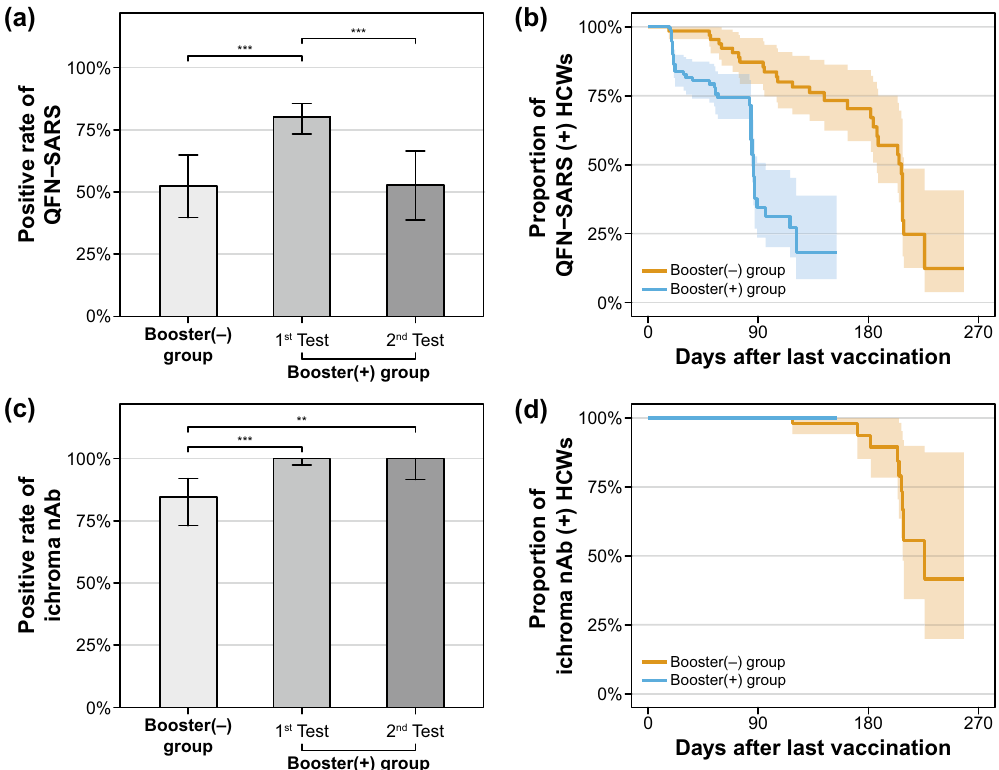
Figure 1. Positive rates of QFN-SARS ( a ) and ichroma nAb ( c ) before and after booster shot. Asterisks indicate significant differences (** p < 0.01, *** p < 0.001), and error bars indicate 95% confidence intervals of the positive rates. Kaplan–Meier curves displaying the proportion of QFN-SARS-positive ( b ) and ichroma nAb-positive ( d ) HCWs with respect to the days elapsed after the final vaccine dose.